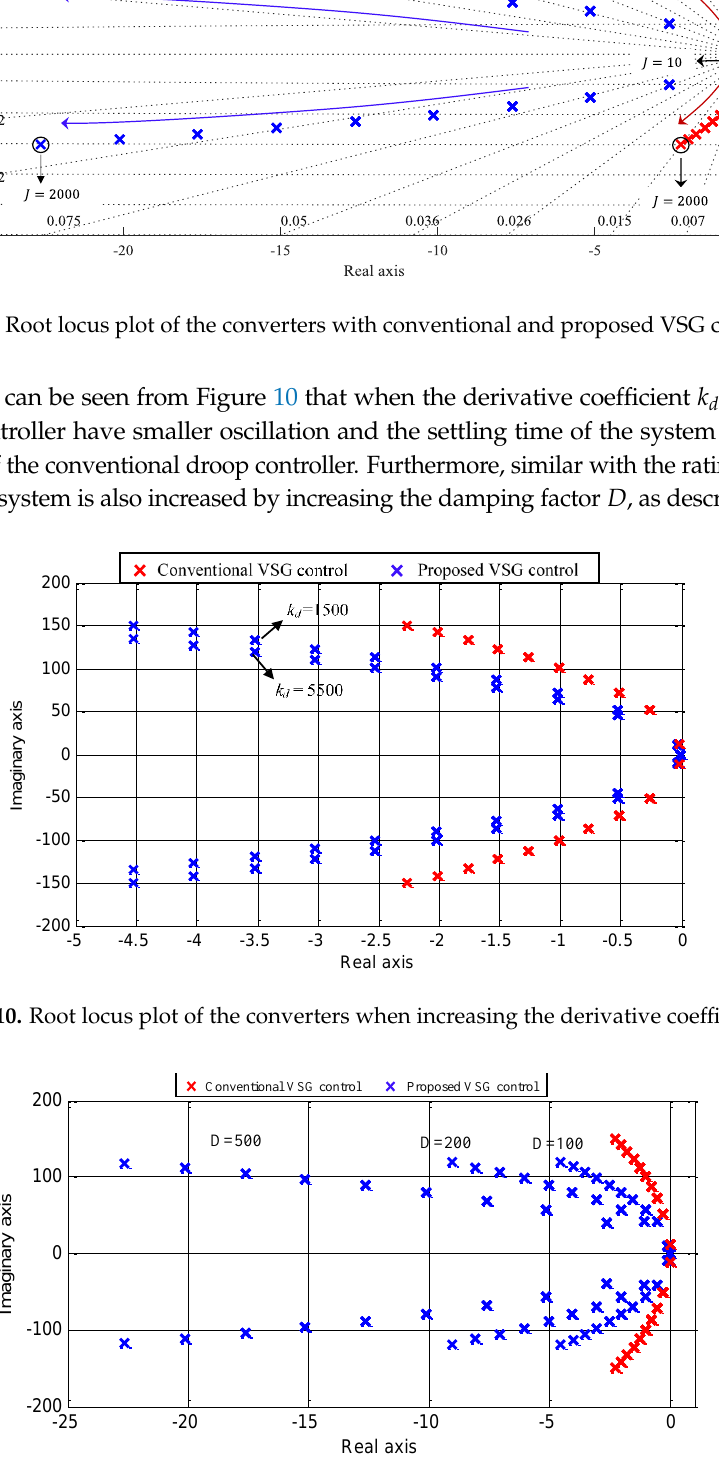
Figure 11. Root locus plot of the converters when increasing the damping factor.